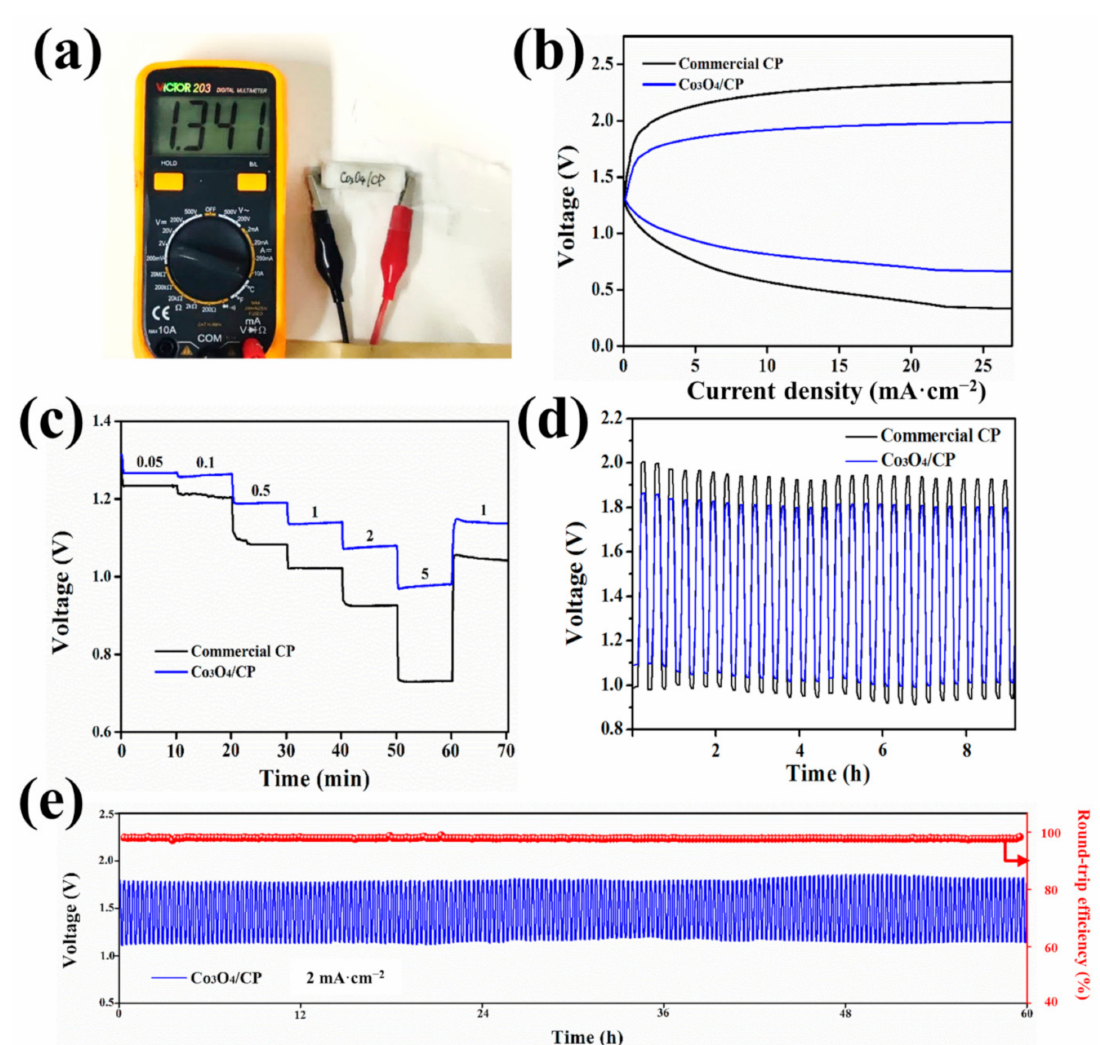
Figure 6. ( a ) Open circuit voltage of Co 3 O 4 /CP-ZAB; ( b ) Comparison of ZAB charge and discharge polarization curves under different electrodes; ( c ) Voltage performance under different discharge currents; ( d ) Comparison of constant current charge and discharge curves of 2 mA cm − 2 ; ( e ) Constant current cycle charge-discharge curve of Co 3 O 4 /CP-ZAB at a current density of 2 mA cm − 2